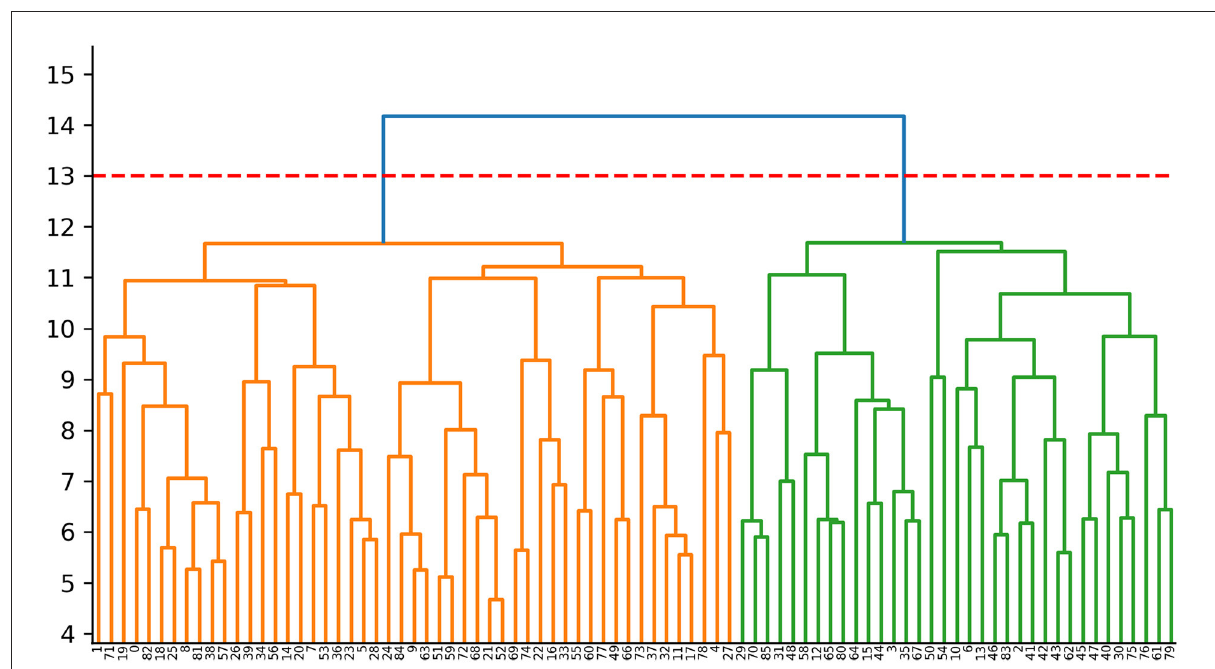
FIGURE1 Dendrogram of the cluster analysis. Cluster 1:The orange area on the left ( n = 51,59.3%); Cluster 2:The green area on the right ( n = 35, 40.7%).